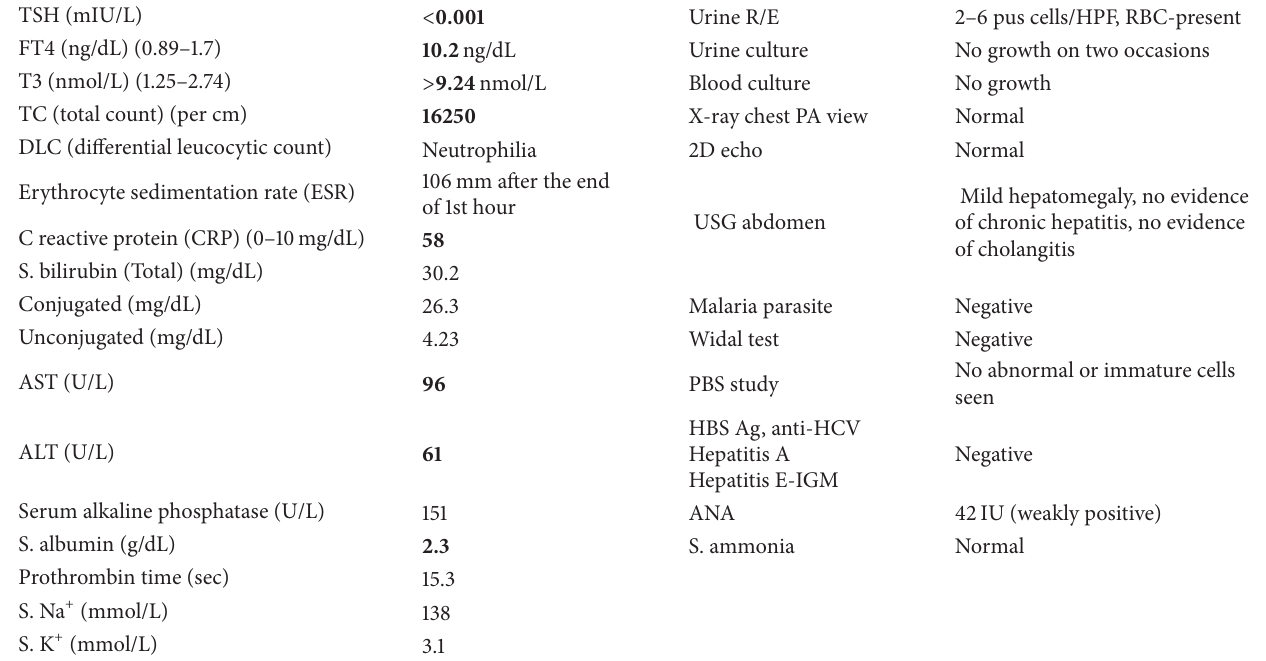
Table 3: Investigations of the patient at